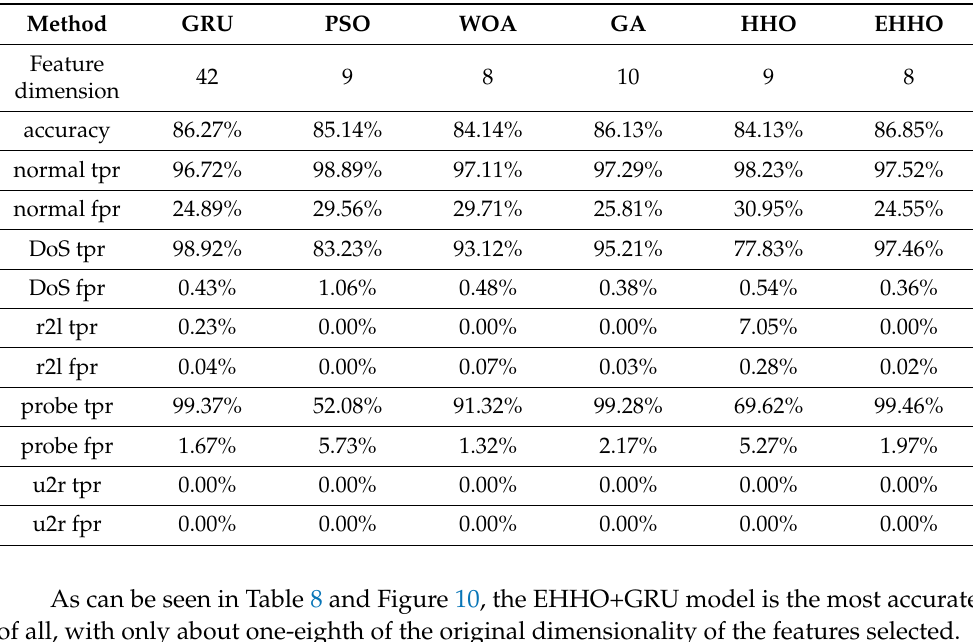
Table 8. Multi-classification experimental results of NSL-KDD.